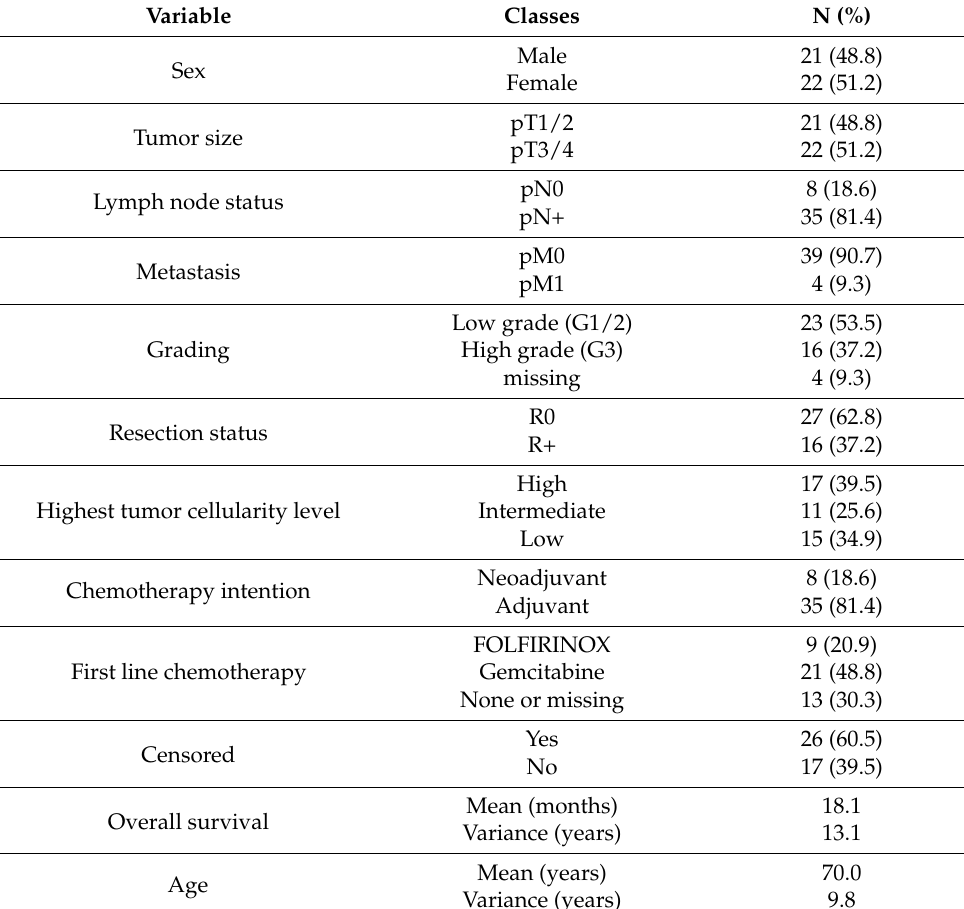
Table 1. Clinical and histopathological data of 43 patients included in the study.